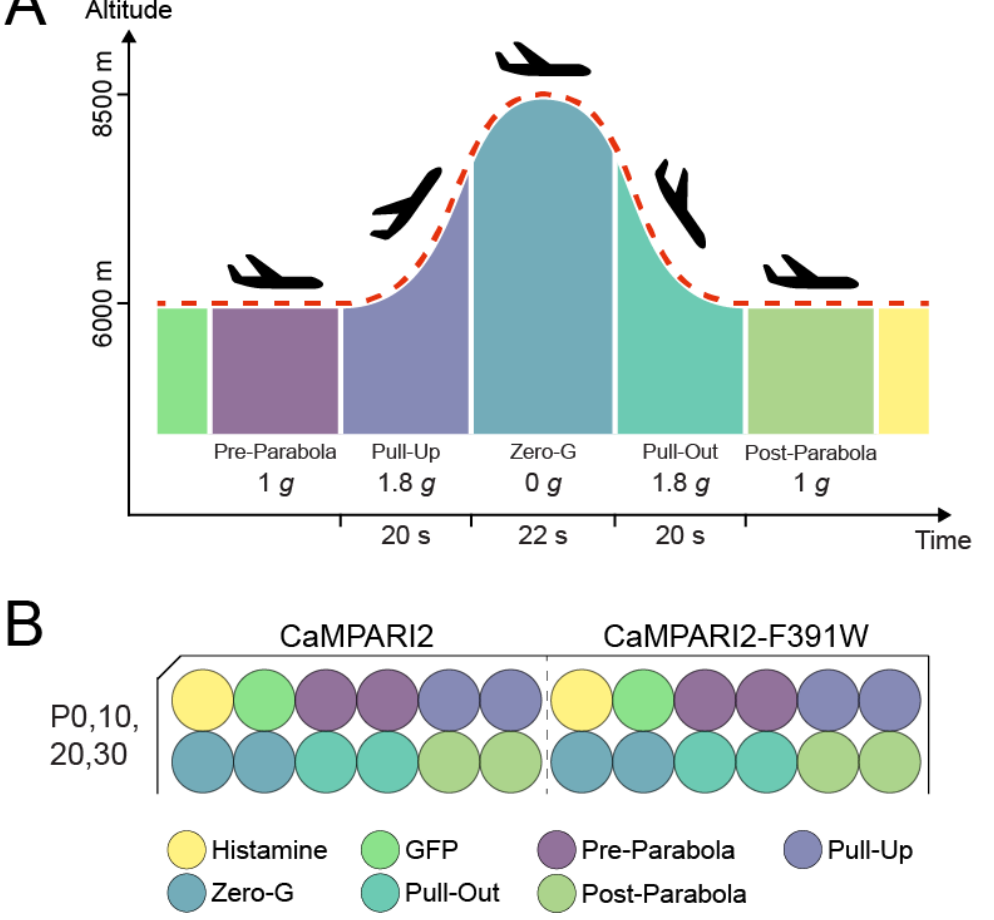
Figure 1. Graphical scheme of the parabolic flight experiment. ( A ) Scheme of the parabolic flight showing the different flight phases and acceleration. ( B ) Transfection ‐ layout of the 96 ‐ well plates with C28/I2 cells. In the left half of the 96 ‐ well plate, the cells were transfected with CaMPARI2, while in the right half the cells were transfected with CaMPARI2 ‐ F391W. In each half, one LED could be activated at the same time. In each depicted parabola, the first wells illuminated were the GFP (green) transfected cells, followed by the first well of the Pre ‐ Parabola phase, etc. Every well was illuminated for 8 s with 405 nm LEDs with 1.1 W radiant flux.